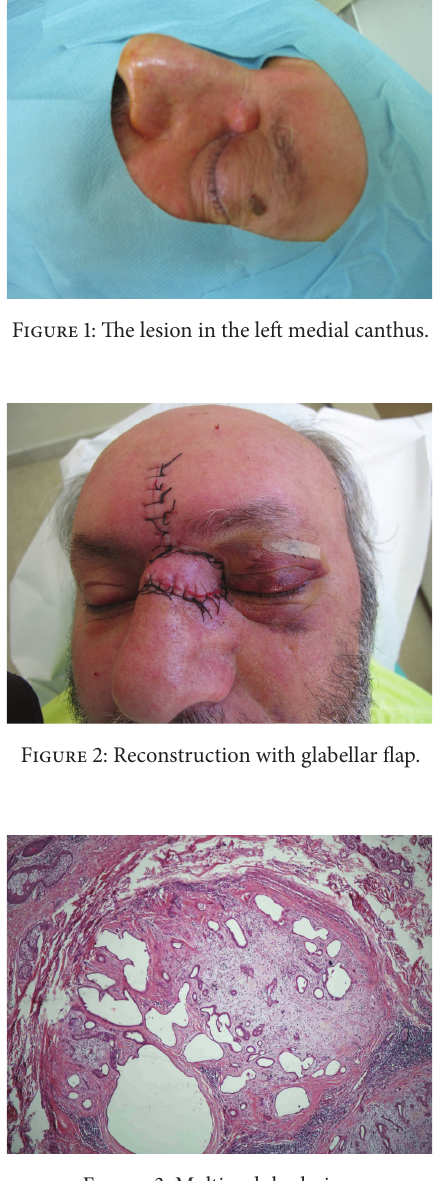
Figure 3: Multinodular lesion.